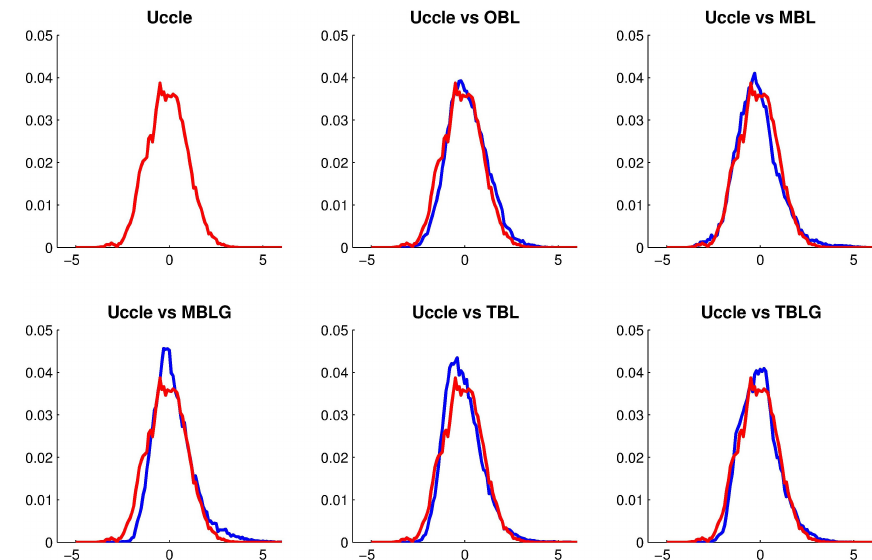
Fig. 2. Comparison between frequency distributions of EDI values of observed and simulated data: Uccle (red), BL models (blue).